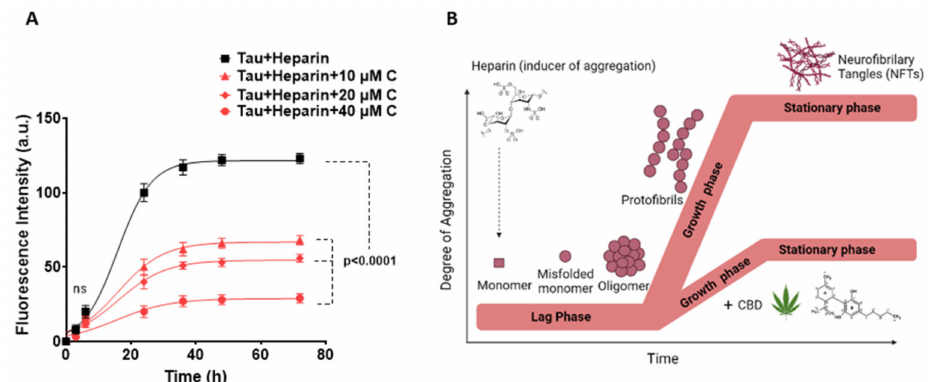
Figure 2. Aggregation kinetics of heparin-induced tau protein in the absence and presence of CBD. ( A ) ThT fluorescence assay to evaluate the kinetics of tau protein aggregation in the absence and presence of 10, 20 and 40 µ M CBD after pre-induction with heparin. The aggregation kinetics of tau is plotted as fluorescence intensity of tau protein (a.u.) vs. time (h). The best-fitting curves for aggregation kinetics of tau follow a sigmoidal profile and a reduced rate appears in the presence of 10, 20, and 40 µ M CBD. In addition, the kinetic changes of aggregation of tau alone were measured as zero constantly over time, so this result is not added in the kinetics plot. ( B ) Schematic representation of the three phases in the tau protein aggregation including lag phase, growth phase, and steady phase using the heparin inducer in the presence and absence of CBD. All data points are given as mean ± SD of three independent experiments ( n = 3). P -value < 0.0001 is considered as statistically significant as determined by one-way ANOVA (Dunnet test) for the comparison between each data point vs. tau +